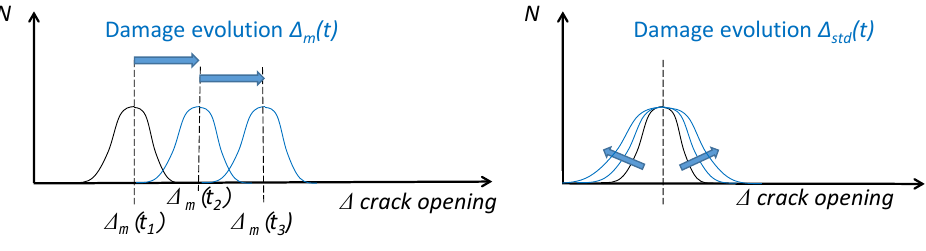
Figure 12. Damage development.